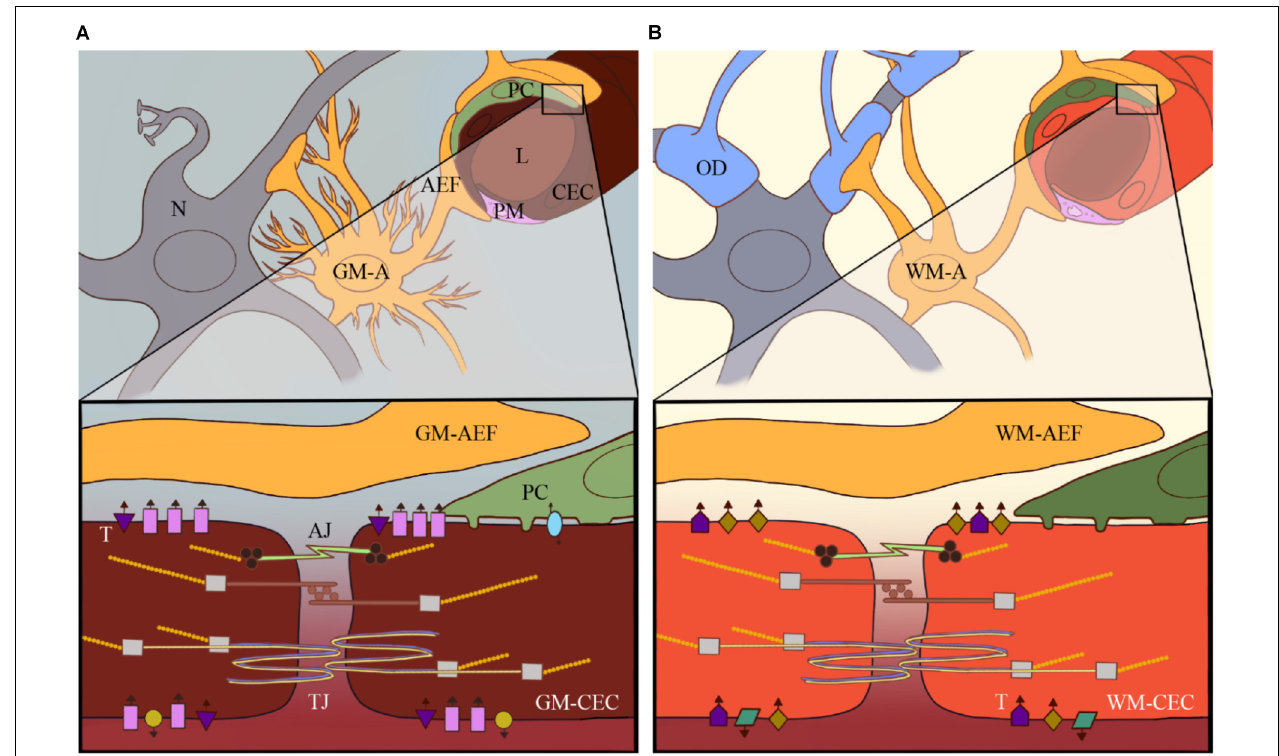
FIGURE 1 | Heterogeneity of the neurovascular unit (NVU): current research has revealed high heterogeneity of e.g., astrocytes and pericytes within the CNS and among different brain areas. The heterogeneity of these different cellular components of the NVU in, for example, the GM (A) versus the WM (B) contributes to brain vascular heterogeneity to support local physiological and metabolic needs for that particular part of the brain. This includes differential expression of specific receptors and transporters on CECs, such as GLUT-1, Pgp and Na + /K + -ATPase, which are represented by the different shapes and colors in GM (A) versus WM-CECs (B) .